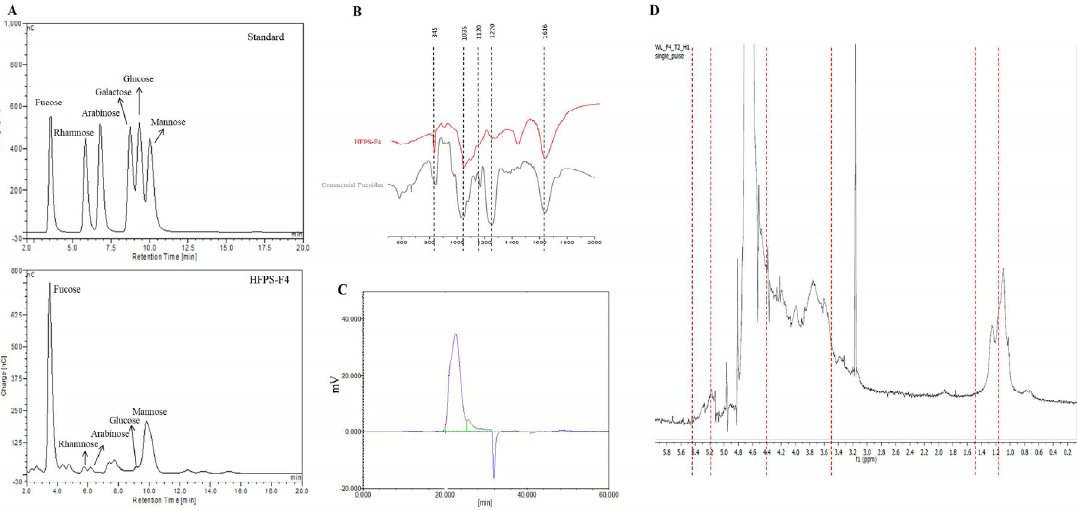
Figure 2. Chemical characterization of HFPS-F4. ( A ) High-performance anion-exchange chromatography (HPAE-PAD) spectrum of standard monosaccharide and HFPS-F4; ( B ) FT-IR spectra of HFPS-F4; ( C ) gel permeation chromatogram of HFPS-F4; ( D ) 1 H NMR spectra of